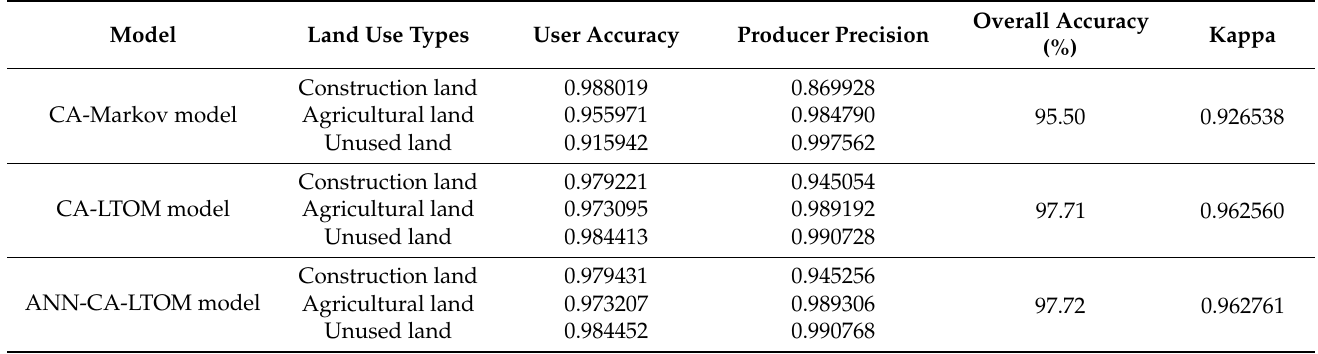
Table 8. Consistency between simulations using different models and observed land use classification in Nansha District in 2020.